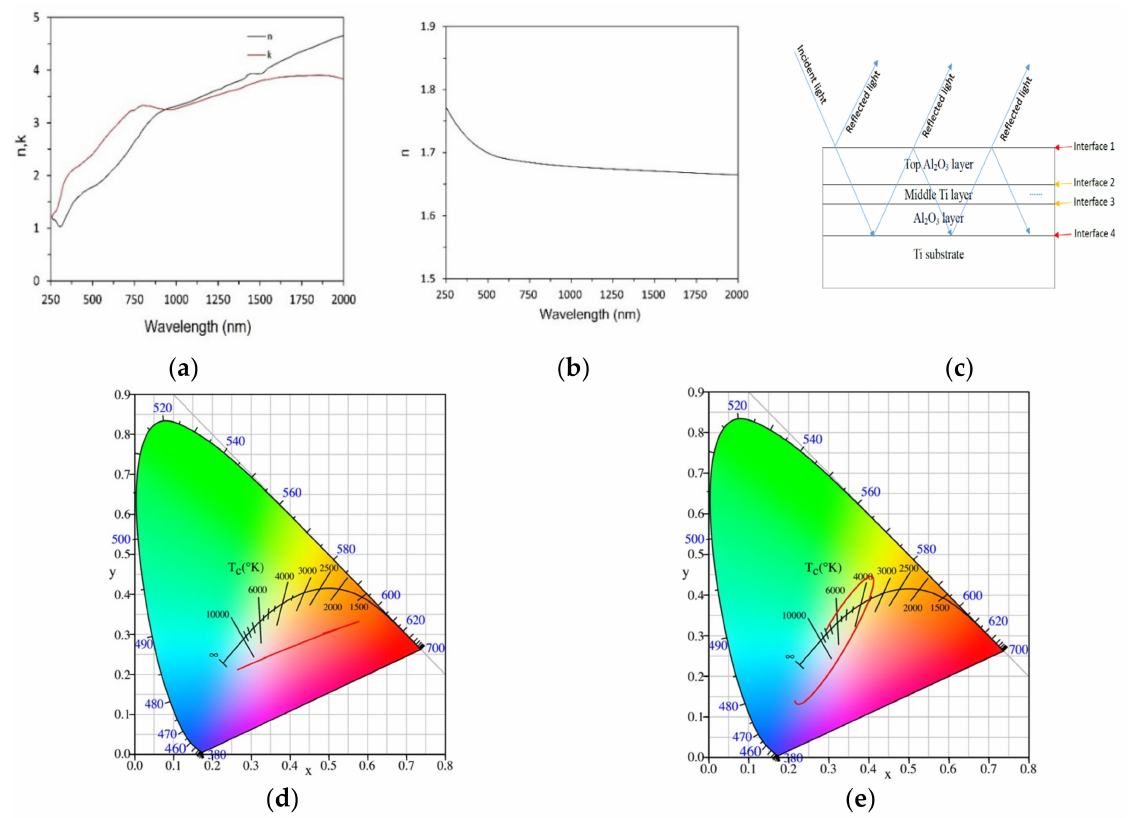
Figure 1. ( a ) n and k for Ti and ( b ) n for Al 2 O 3 films with k = 0. ( c ) Simple experimental schematic for the absorber. Color distribution of Al 2 O 3 /Ti/Al 2 O 3 multilayer stacks with layer thicknesses of ( d ) 55/20/X and ( e ) 70/14/X. X is the thickness of the third layer (Al 2 O 3 ). The layer thickness unit is